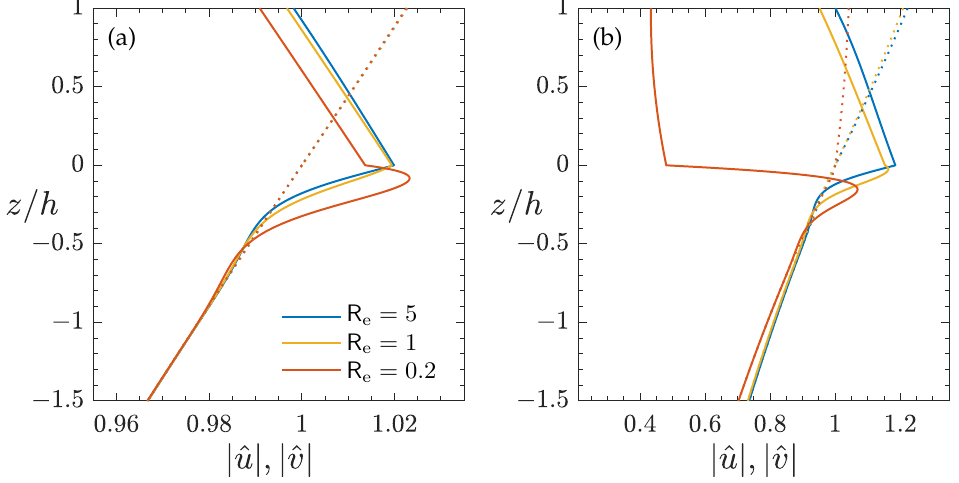
Figure 8. Velocity amplitudes effects of ice-layer viscosity: ( a ) ˜ ω = 0.15, ( b ) ˜ ω = 0.45. Solid curves: The vertical velocity amplitude presence of WBL in water, and closely follows the solution for an irrotational